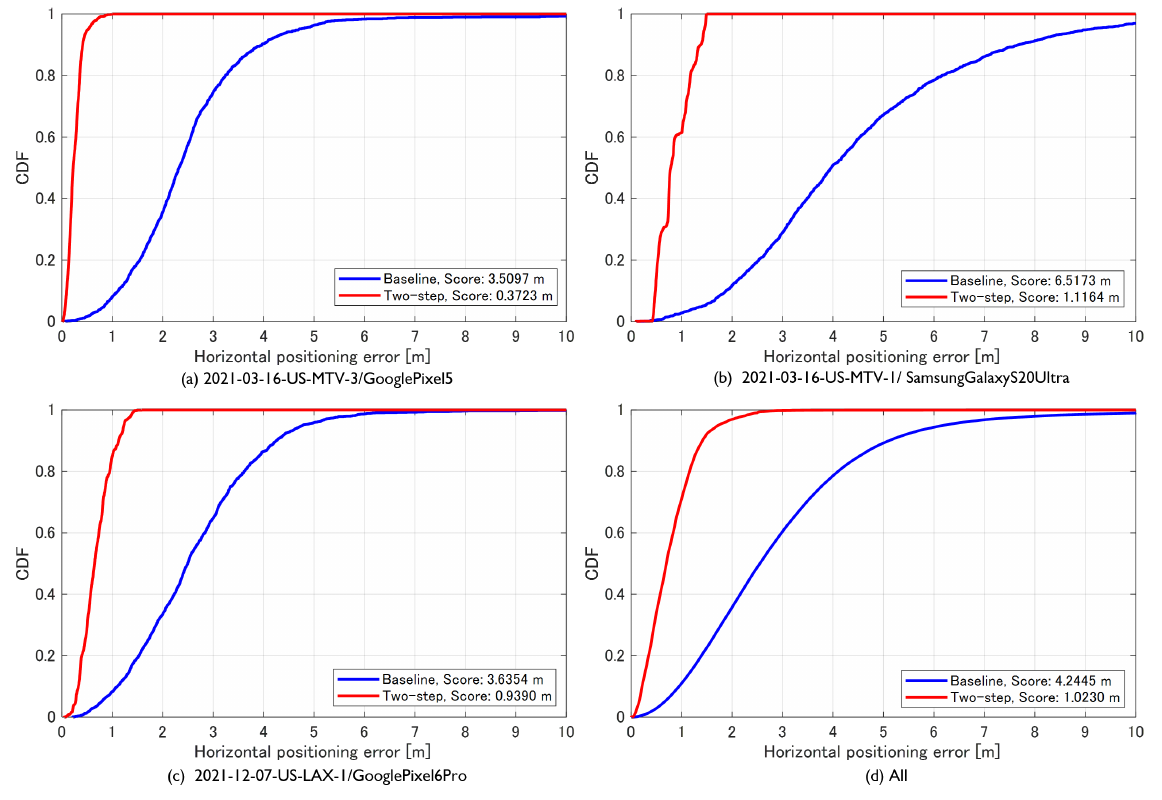
Figure 10. Comparison of horizontal cumulative distribution function (CDF) for each run and the entire evaluation dataset. The blue and red lines represent the baseline and proposed method, respectively. Table 2. Comparison of positioning error between baseline and proposed